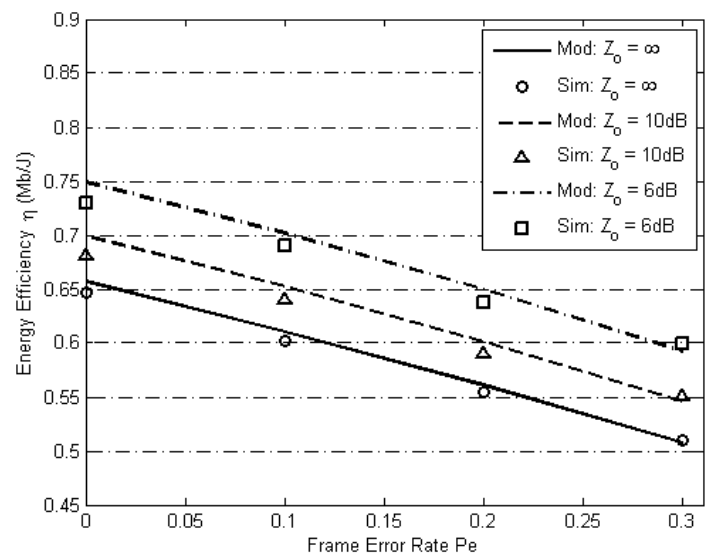
Figure 4. Energy efficiency against varying frame error rate in the presence and absence of capture.